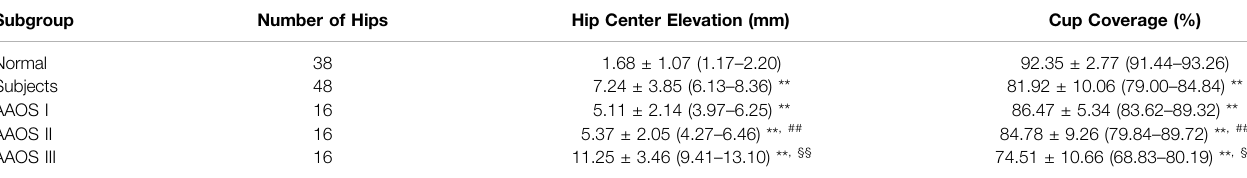
TABLE 3 | Hip center and cup coverage measurements of acetabular cup. Subgroup